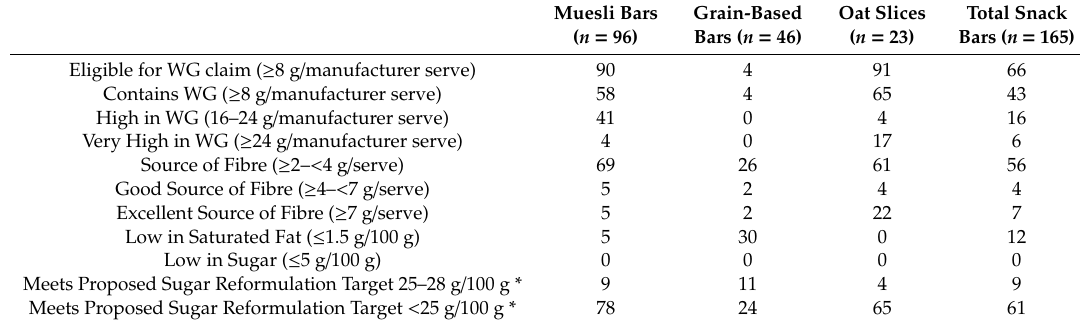
Table 4. Percentage of products meeting claim criteria and proposed reformulation targets *.